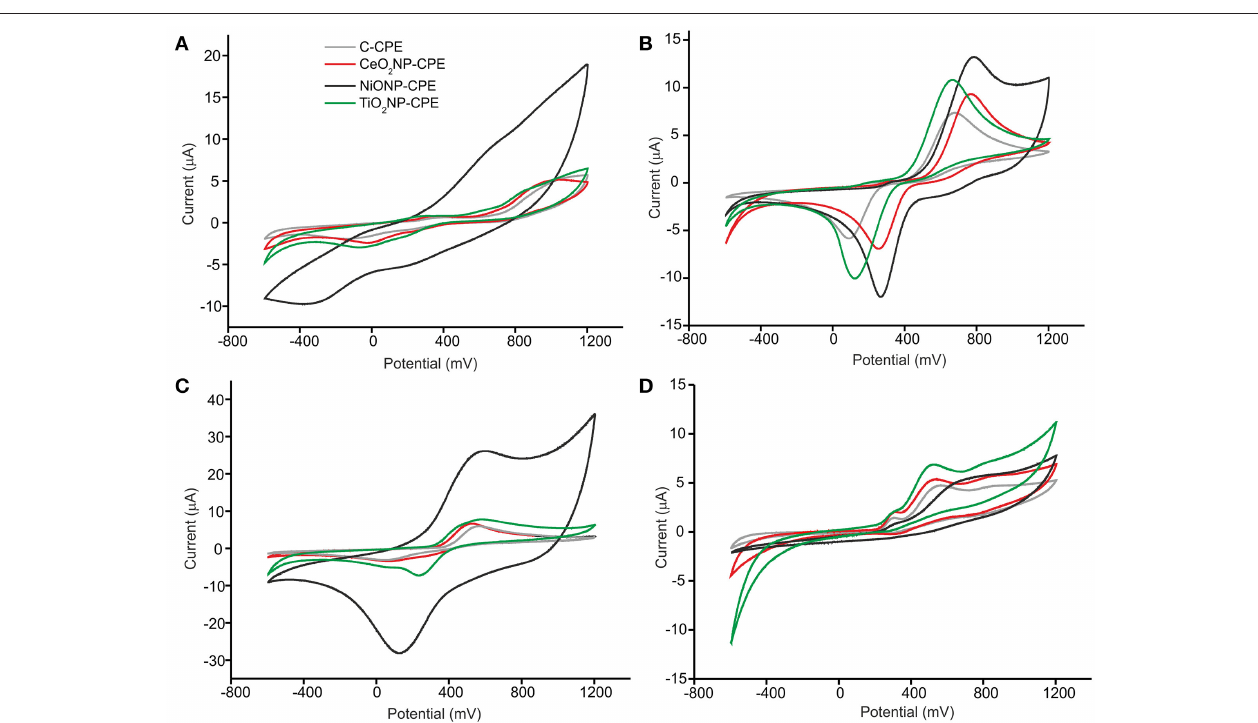
FIGURE 3 | CV of (A) vanillic acid, (B) catechol, (C) caffeic acid, and (D) pyrogaloll at C-CPE, CeO 2 NP-CPE, NiONP-CPE, and TiO 2 NP-CPE electrodes. Concentration of 10 − 4 M. Scan rate 100 mV · s − 1 .